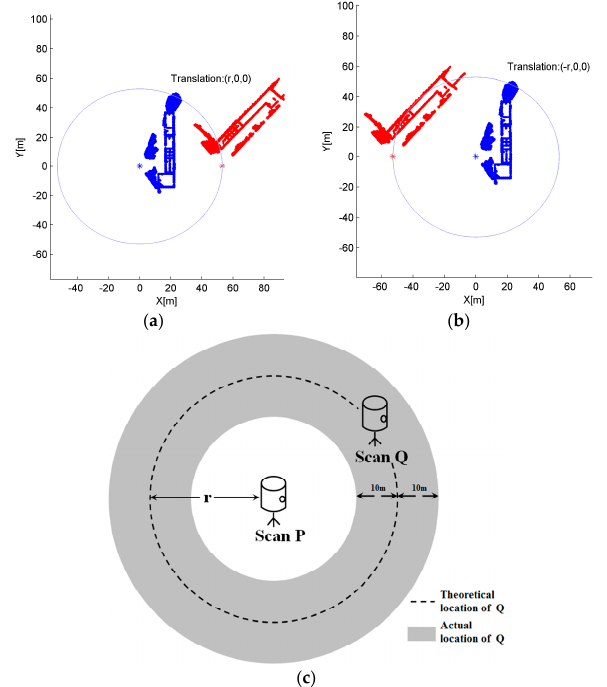
Figure 1. Relation between P and Q: ( a , b ) two different postures of P and Q with the same distance r, and the distance r is not enough to recover the transformation between them; and ( c ) the uncertainty of Q’s location.